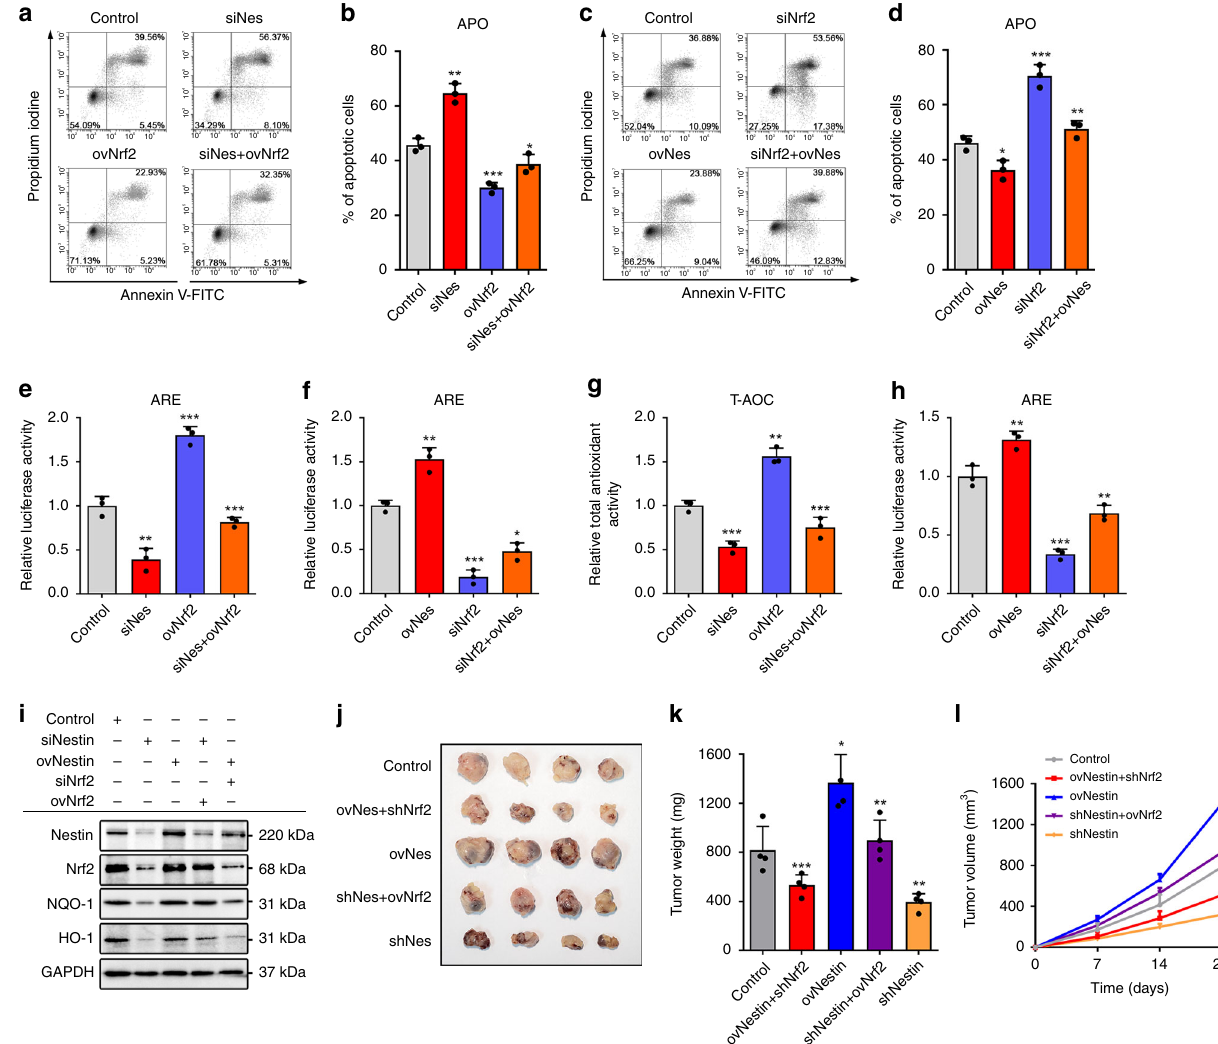
Fig. 7 Nestin and Nrf2 cooperatively contribute to the antioxidant stress capacity of NSCLC cells. a Flow cytometric analysis performed with Annexin V- FITC and PI was used to detect apoptosis of A549-con, A549-siNestin, A549-ovNrf2, and A549-siNestinovNrf2 cells, respectively. b Statistical analysis of the total apoptosis rate in A549 cells described in a. c Flow cytometric analysis with Annexin V-FITC and PI was used to detect apoptosis of A549-con, A549-siNrf2, A549-ovNestin, and A549-siNrf2ovNestin cells, respectively. d Statistical analysis of the total apoptosis rate in A549 cells described in c . e A549 cells were transiently treated with siNestin RNA and/or ovNrf2 plasmids, transiently transfected with an ARE-driven luciferase reporter gene construct, harvested, and assayed for luciferase activity. f A549 cells were transiently treated with siNrf2 RNA and/or ovNestin plasmids, transiently transfected with an ARE luciferase reporter gene construct, harvested, and assayed for luciferase activity. g Total antioxidant activity (T-AOC) was assayed in A549 cells that had been transfected with siNestin RNA and/or ovNrf2 plasmids. h Total antioxidant activity (T-AOC) was assayed in A549 cells that had been transfected with siNrf2 RNA and/or ovNestin plasmids. i Western blotting analysis was performed to evaluate the levels of NQO1 and HO-1 in A549 cells transfected with siNestin, ovNestin, siNestinovNrf2, or siNrf2ovNestin. j , k Nude mice were randomized into fi ve groups ( n = 4 per group) and subcutaneously injected with A549 cells that had been transfected with control, shNestin, ovNestin, shNestinovNrf2, or ovNestinshNrf2 plasmids. Tumors formed in nude mice were collected 21 days after grafting, and the tumor weight were measured. l The tumor volume (growth rate) was measured over time. Data are presented as the means ± SD of at least three independent experiments. * P < 0.05, ** P < 0.01, and *** P < 0.001, Student ’ s t test. Source data are available as a Source Data fi